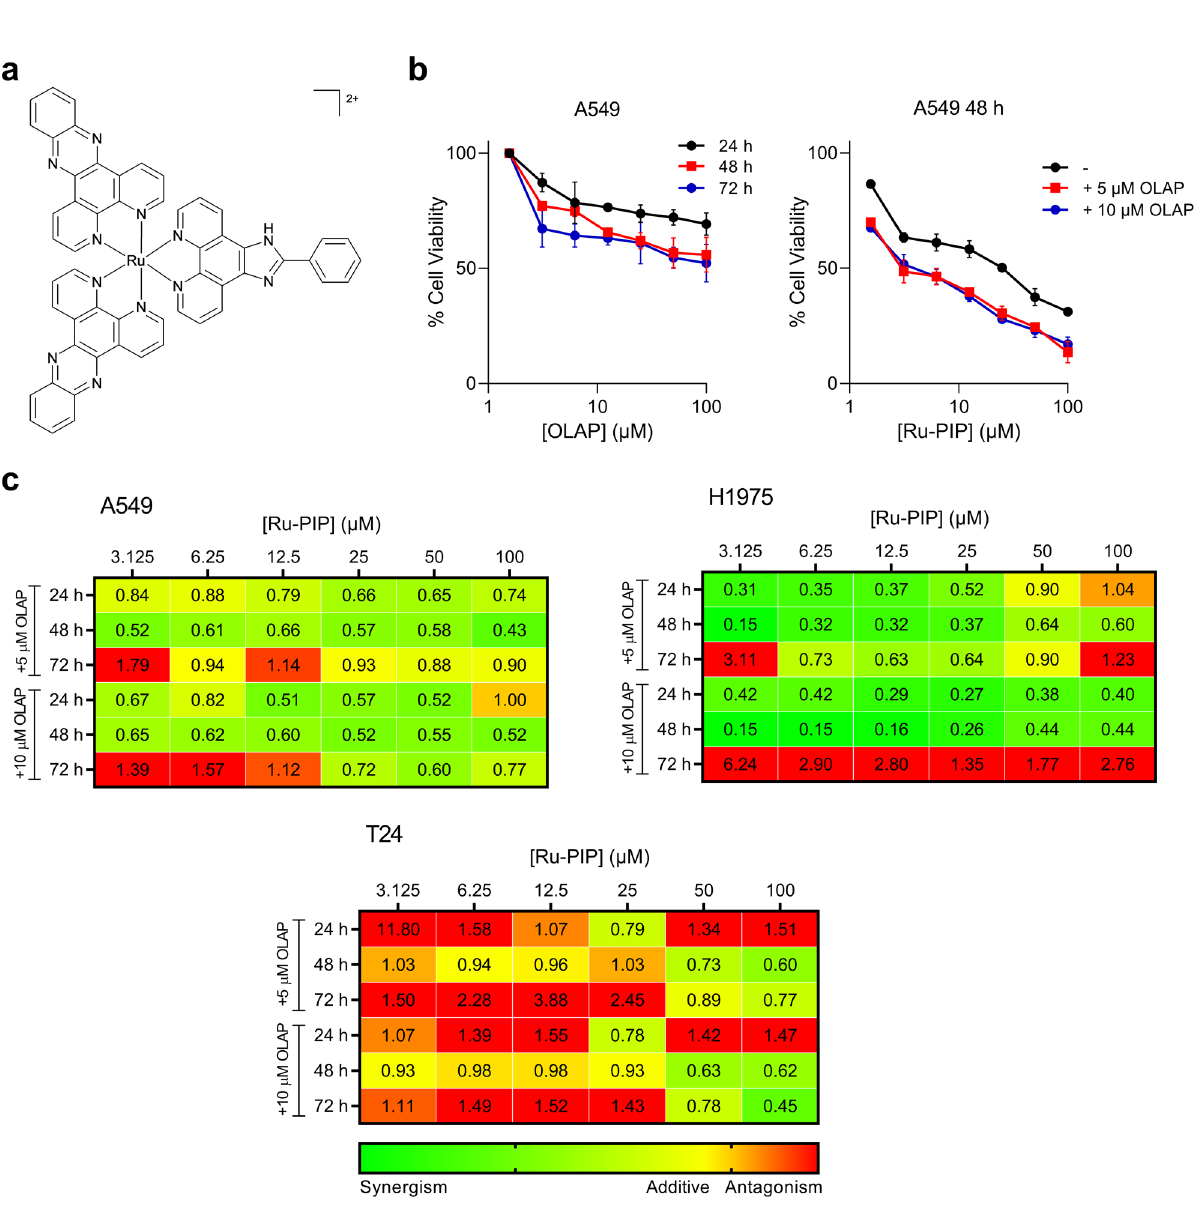
Figure 1. Ru-PIP synergizes with Olaparib in lung cancer cells. ( a ) Structure of Ru-PIP. ( b ) Left, cell viability of A549 cells upon treatment with Olaparib (OLAP). Right, cell viability of A549 cells upon treatment with Ru-PIP alone or in combination with Olaparib at 48 h. Mean ± SD of three independent experiments. ( c ) Combination indices (CIs) for Ru-PIP and Olaparib combinations in A549, H1975 and T24 cells for 24, 48 and 72 h treatment. CI values were calculated using CompuSyn software, and a heat map was generated as described within Methods section.